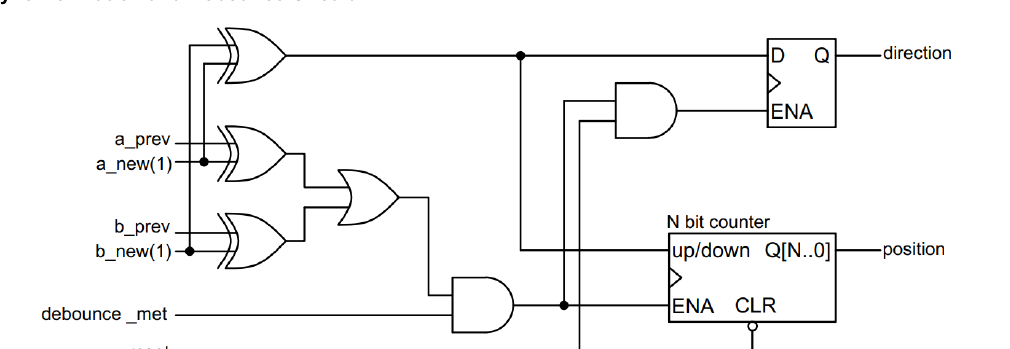
Figure 4. Synchronization and Debounce Circuit